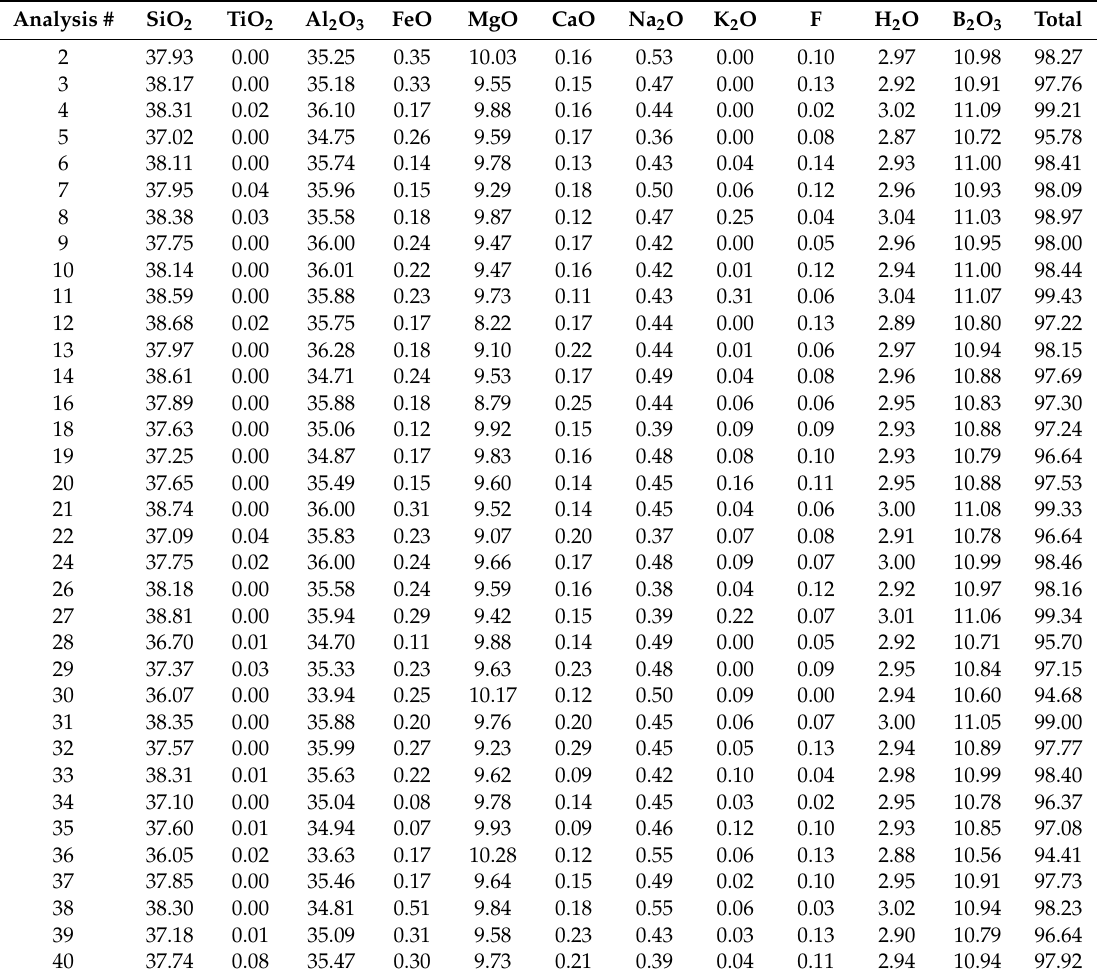
Table 1. Chemical composition (wt.%) of tourmaline T1 (EPMA) and calculated H 2 O and B 2 O 3 compositions with the WinTcac software